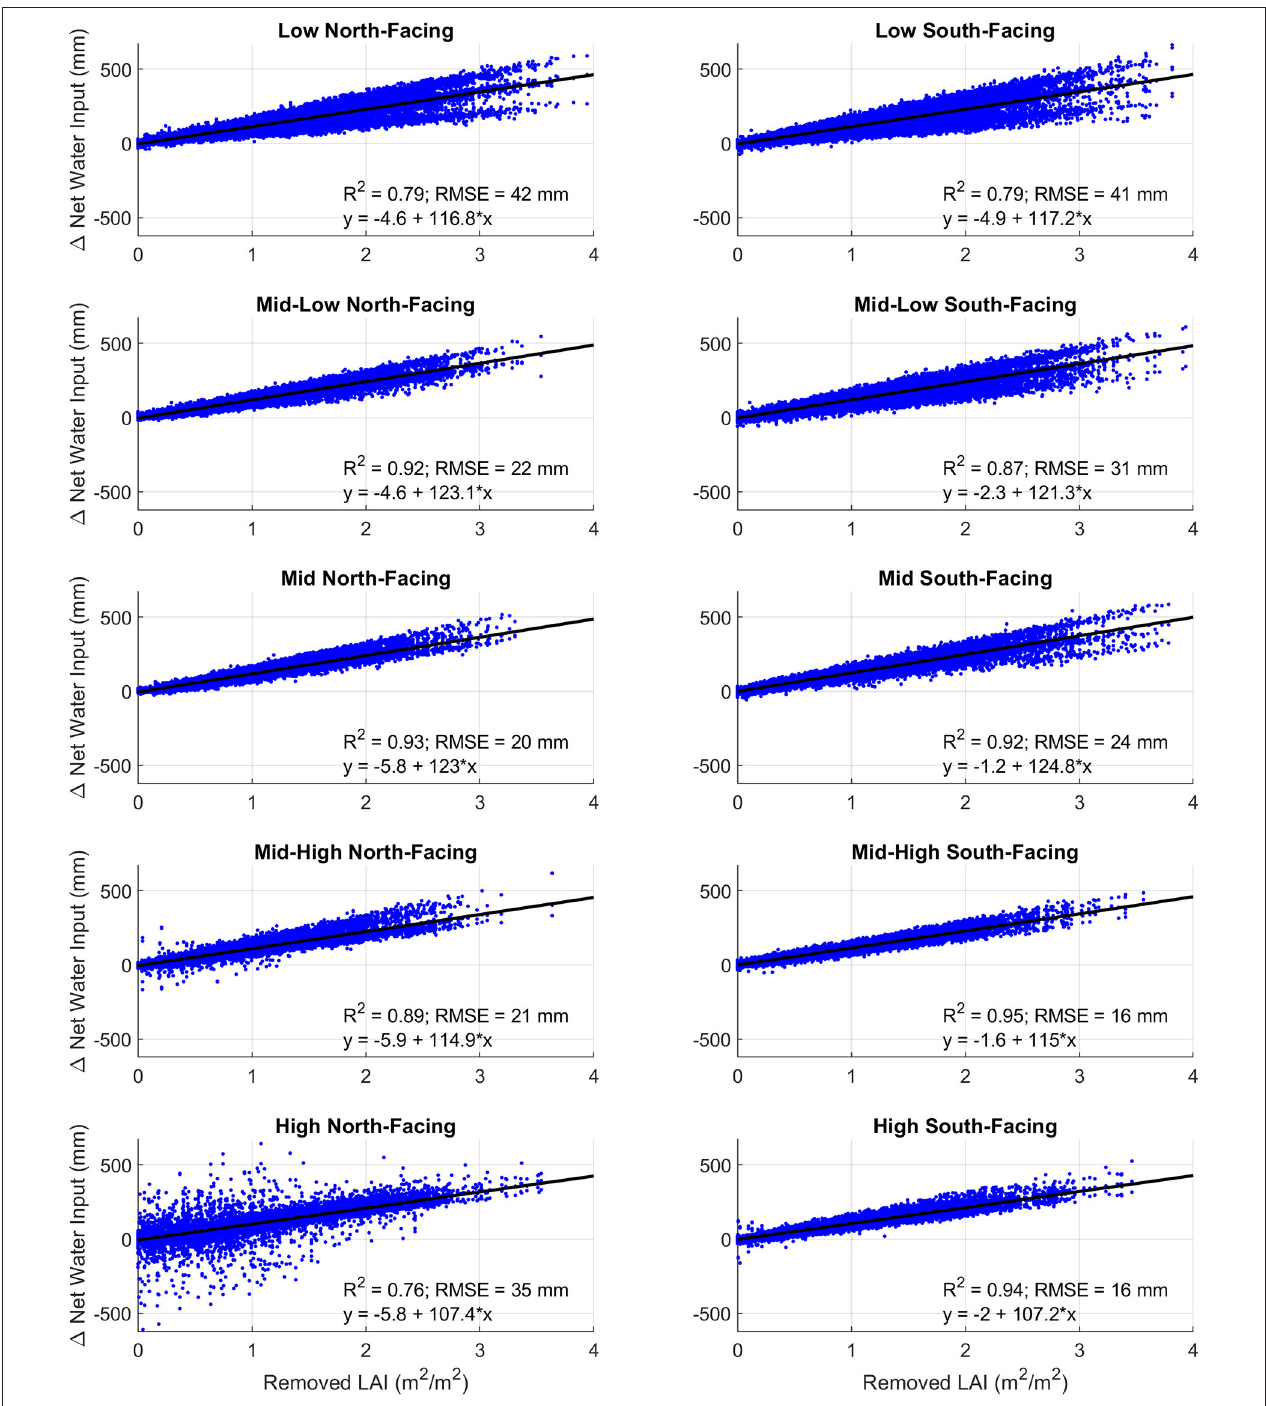
FIGURE 5 | Forest patch (30m) relationships between changes in net water input and removed LAI for the two thinning scenarios and the three water years across Snow Zones.